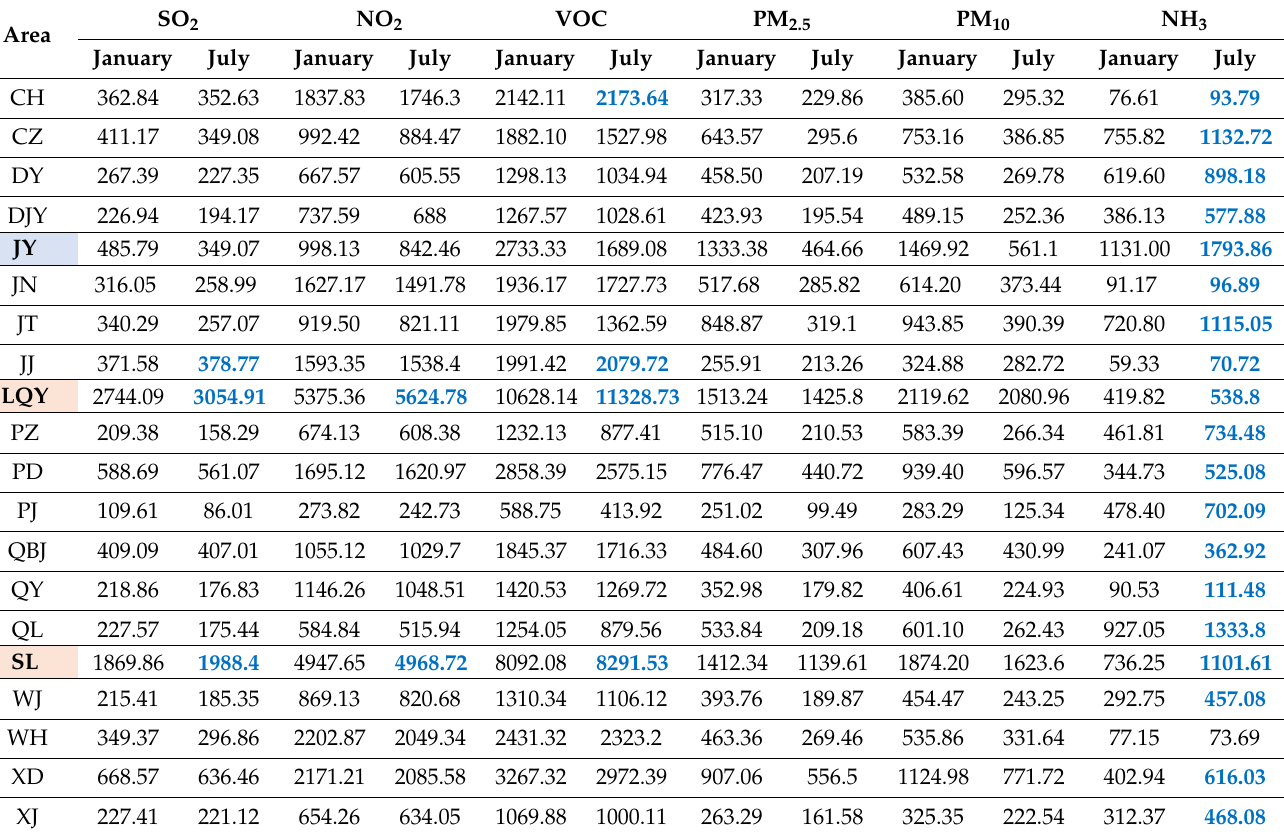
Table 3. Pollutant emissions by region in Chengdu in January 2017 (units: t), July’s higher pollutant emissions than January are marked by blue